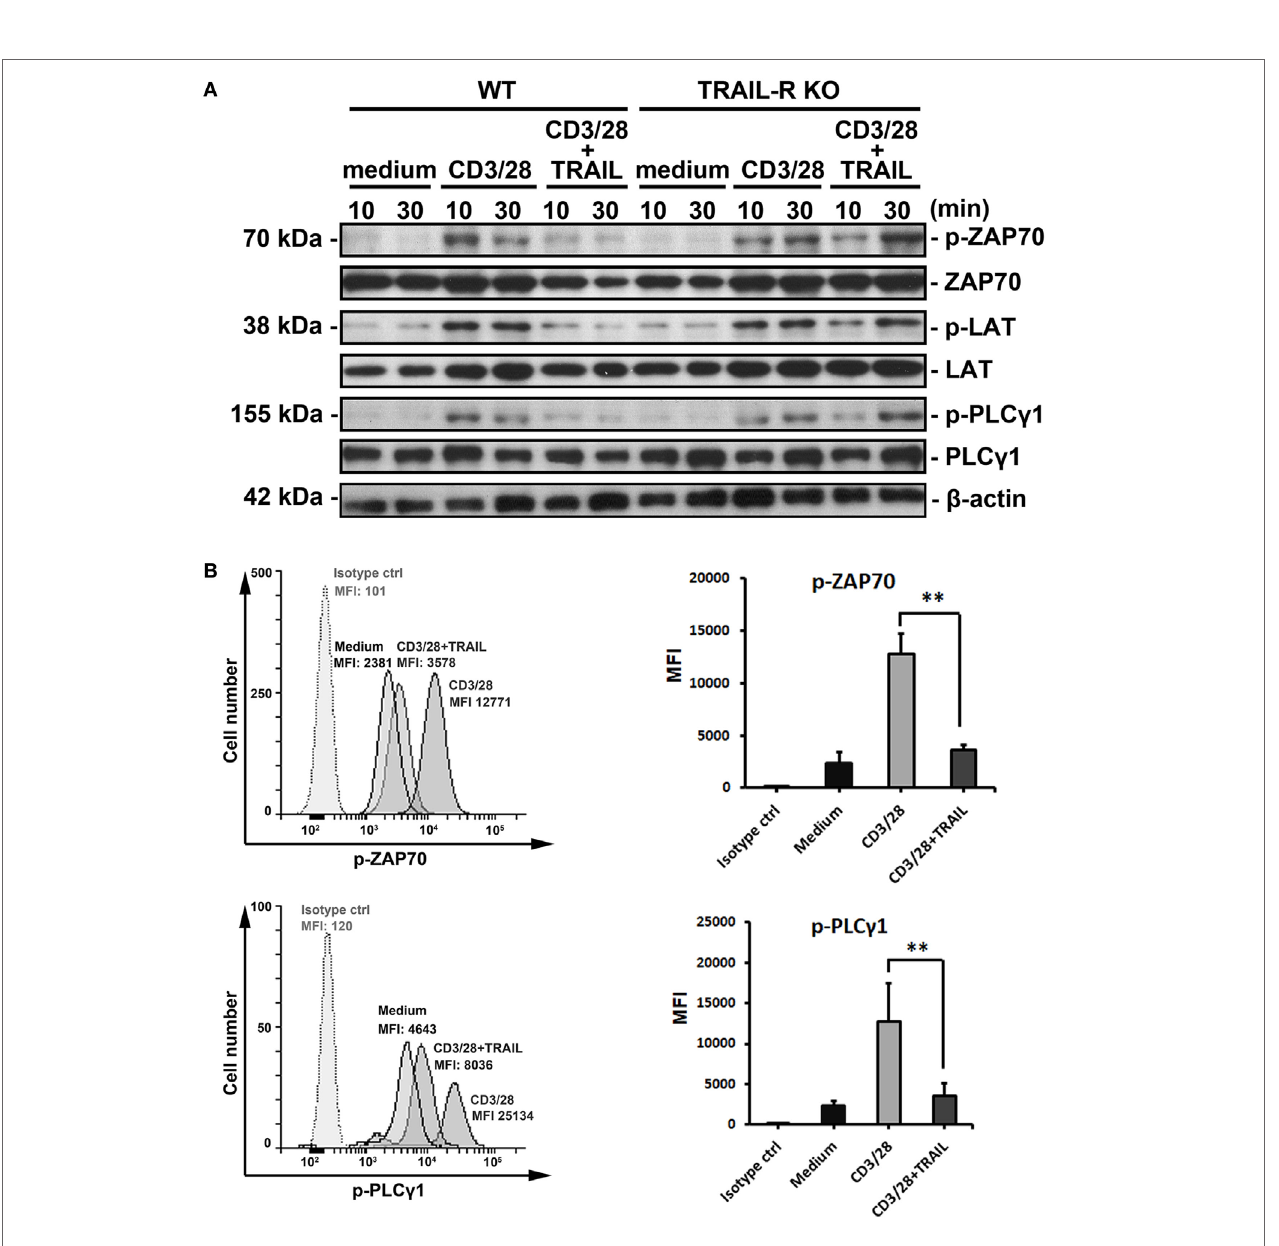
FigUre 5 | Downregulated T cell receptor (TCR) signaling-associated genes in TRAIL-treated mice with experimental autoimmune encephalomyelitis (EAE). C57BL/6 mice were immunized with the myelin oligodendrocyte glycoprotein 35–55 peptide (200 µg/mouse, s.c.) in a complete Freund’s adjuvant emulsion on day 0 followed by pertussis toxin (250 ng/mouse, i.p.) on days 0 and 1. Beginning on day 2 after immunization, mice were treated daily with vehicle (200 µl/mouse/day, i.p.) or TRAIL (100 µg/mouse/day, i.p.). On day 15 after immunization, splenic CD4 + T cells were isolated from control and EAE mice after treatment with the vehicle or TRAIL. Total RNA of splenic CD4 + T cells from each group was extracted and sequenced on the Solexa platform (Illumina), as described in Section “Materials and Methods.” (a) Venn diagram showing the overlap among nominally significant genes of splenic CD4 + T cells from each group. (B) The number of significant genes in splenic CD4 + T cells from TRAIL-treated mice compared to vehicle-treated mice was plotted following a Kyoto Encyclopedia of Genes and Genomes (KEGG) pathway analysis. (c) Volcano plot showing distribution of up- and downregulated genes in splenic CD4 + T cells from TRAIL-treated mice compared to vehicle- treated mice following a KEGG pathway analysis. Significantly up- and downregulated genes are highlighted. (D) Heatmap representing gene expressions of splenic CD4 + T cells from each group. Only the most significant genes in TCR signaling and the cell cycle from the KEGG pathway analysis are shown. Statistical analysis was performed using R. Scale: Red indicates high expression and green is low